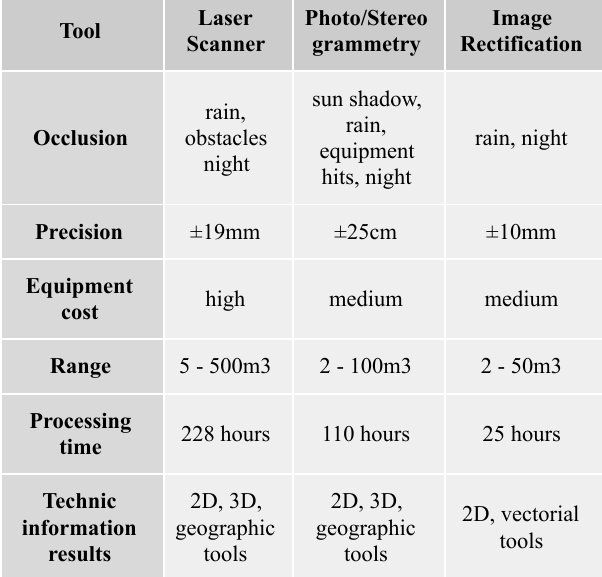
Table 1. Results of the applied documentation tools in the selected case